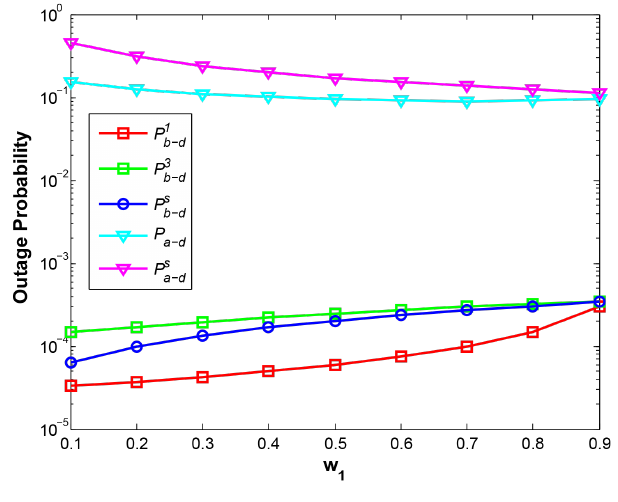
Figure 2. OP vs. w 1 at d 1 =